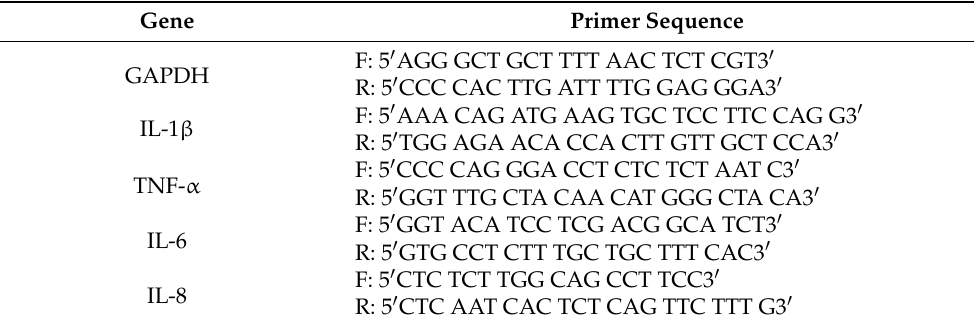
Table 1. RT-PCR primers used in this